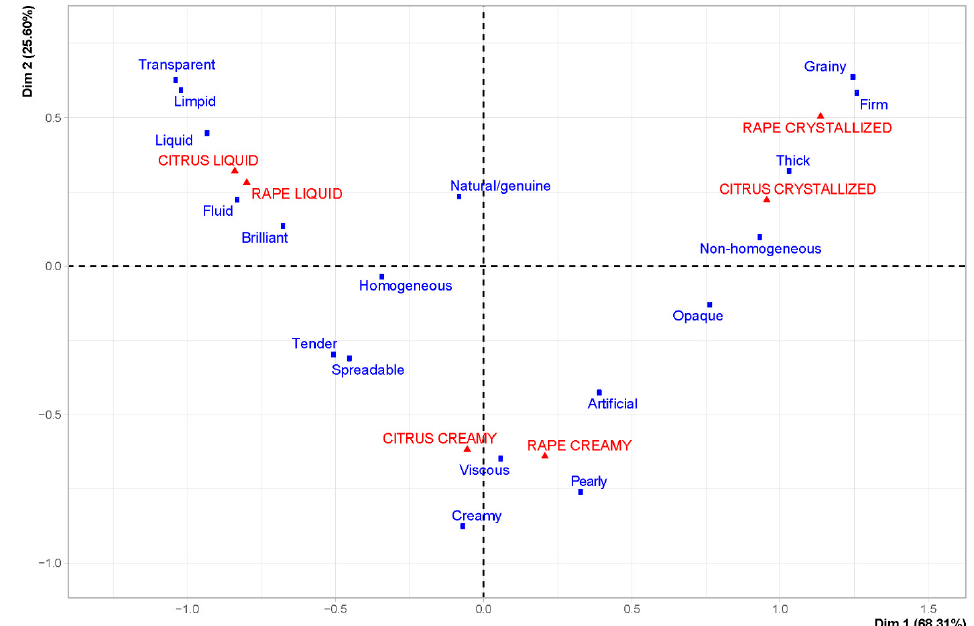
Figure 7. CA of visual/texture CATA terms and the six honeys evaluated. The first one, composed of two liquid samples, described as transparent, limpid, liq- uid, fluid, brilliant and natural/genuine, was located at negative values of the first dimen- sion and positive values of the second dimension. The crystallized samples were located at positive values of the first and second dimension and were described as firm, grainy, thick and non-homogeneous. Finally, the creamy samples were located at negative values of the second dimension and were described as viscous, pearly, and creamy, but also ar- tificial, especially for rape honey. The terms tender and spreadable are associated with both creamy and liquid samples. The citation frequencies of gustatory CATA terms used to describe citrus and rape honeys are reported in Table 13. Table 13. Cochran’s Q tests for the citation frequencies of the gustatory CATA terms. Term